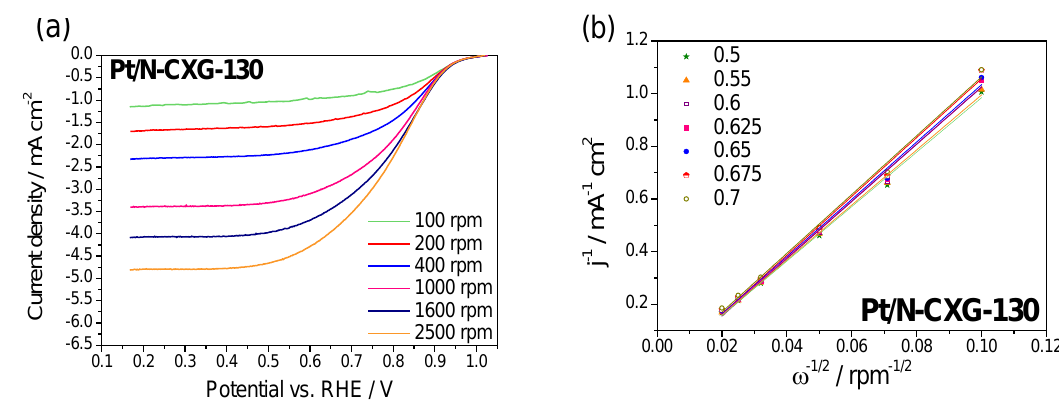
Figure 6. ( a ) LSV curves for Pt/N-CXG-130 at different rotation rates recorded in a 0.5 M H 2 SO 4 O 2 -saturated solution. Scan rate: 5 mV · s − 1 ; ( b ) Koutecky-Levich plots for Pt/N-CXG-130 at different potentials. The legend refers to potential values (V vs. RHE).